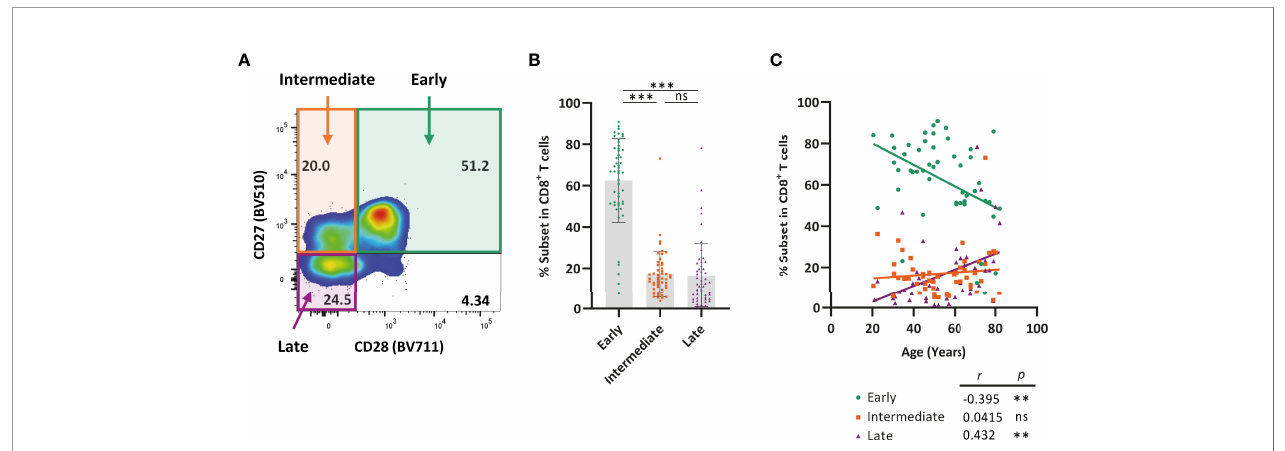
FIGURE 4 | Late-differentiated T cells accumulate with age at the cost of early-differentiated T cells. Expression of CD27 and CD28 by CD8 + T cells was analyzed in healthy individuals ranging from 21-82 years of age (n = 50) using fl ow cytometry. (A) Representative fl ow-cytometry plot illustrating expression of CD27 and CD28 by CD8 + T cells. (B) Bar graphs show the frequency of early (CD27 + CD28 + ), intermediate (CD27 + CD28 - ), and late (CD27 - CD28 - ) differentiated cells within the total CD8 + T-cell population of each individual. (C) Frequency of each of the three differentiation subsets among CD8 + T cells and their relationship with age. Correlations ( r and p values) were assessed by Spearman test. Statistical signi fi cance of data presented in the bar graph (means ± s.d.) was determined using Friedman test (with Dunn ’ s post-test). (** p < 0.01, *** p < 0.001, ns, not signi fi